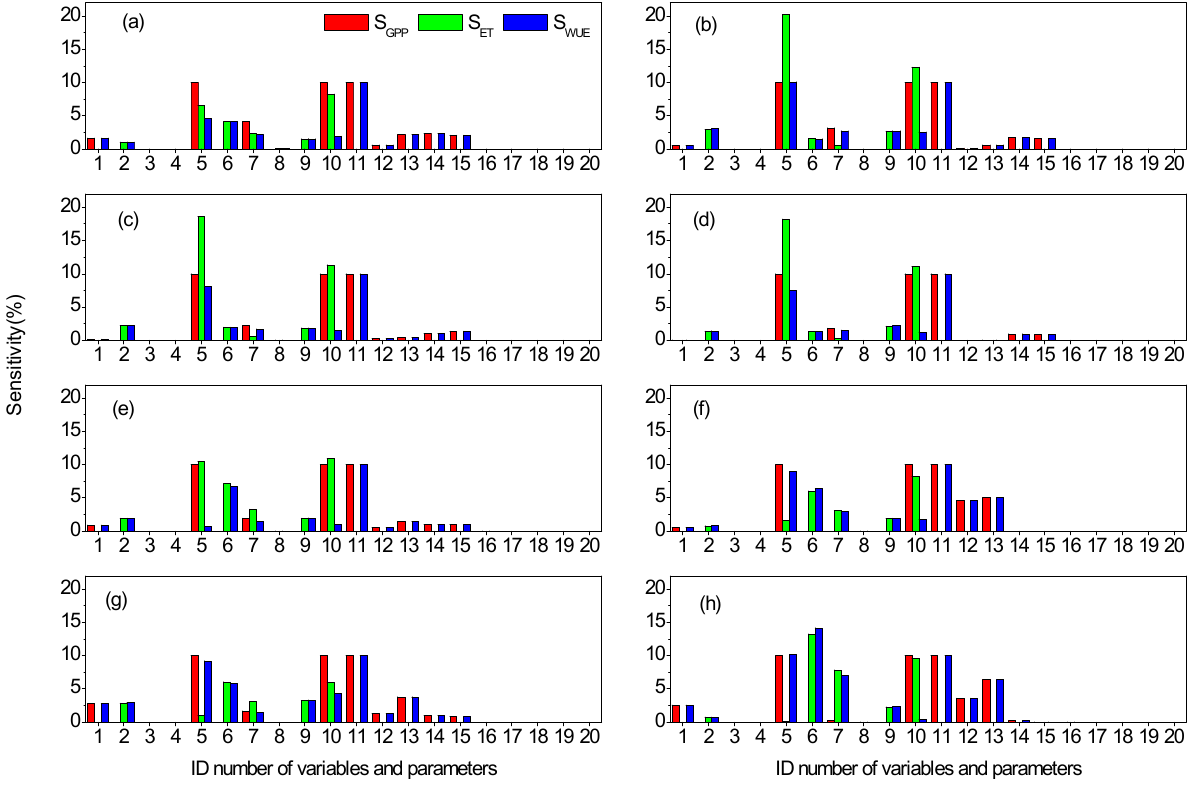
Figure 6. Sensitivities of annual GPP, ET and WUE to driving variables and model parameters with their ID numbers listed in Table 1. ( a ) CBS; ( b ) DHS; ( c ) QYZ; ( d ) XSBN; ( e ) YC; ( f ) HBGC; ( g ) NM; ( h )